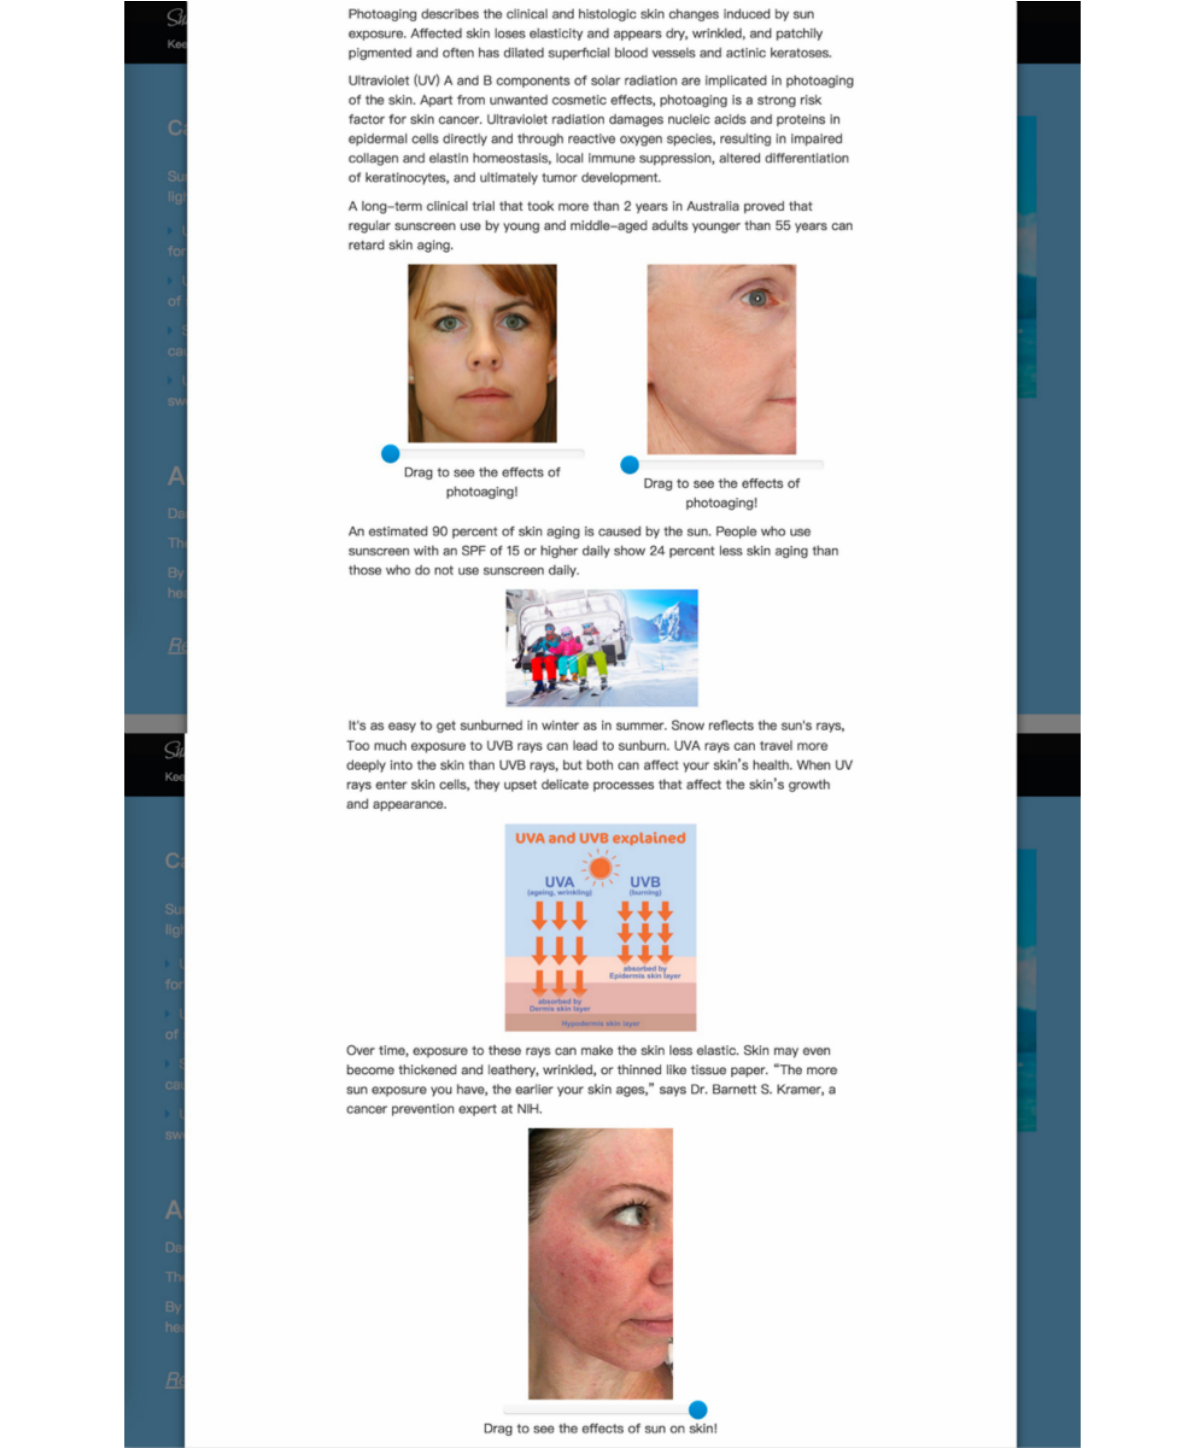
Figure 3. Example of high modality interactivity